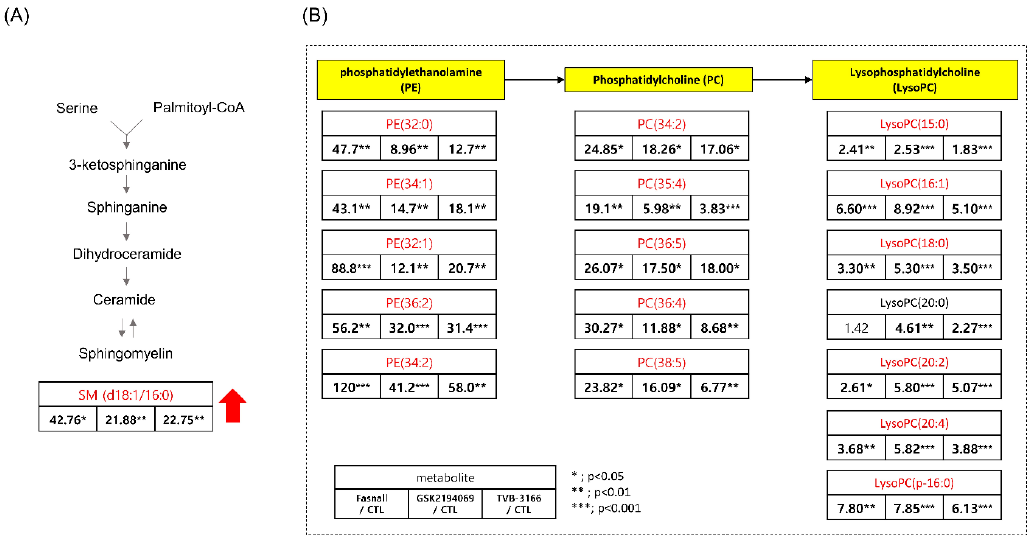
Figure 8. Table showing the fold change in SM(d18:1 / 16:0), PE, PC, and LysoPC in FAS inhibitors ( A ) Table showing the fold change in SM(d18:1 / 16:0) in the Fasnall-, GSK214069-, and TVB-3166-treated groups from metabolomics data (n = 5 per condition), *** p < 0.001, ** p < 0.01, * p < 0.05, Student’s t -test. ( B ) Table showing the fold change in the PE, PC, and LysoPC family in the Fasnall-, GSK214069-, and TVB-3166-treated groups from metabolomics data (n = 5 per condition), *** p < 0.001, ** p < 0.01, * p < 0.05, Student’s t -test. Metabolites in red are the commonly increased metabolites only with Fasnall, GSK2194069, and TVB-3166 drug